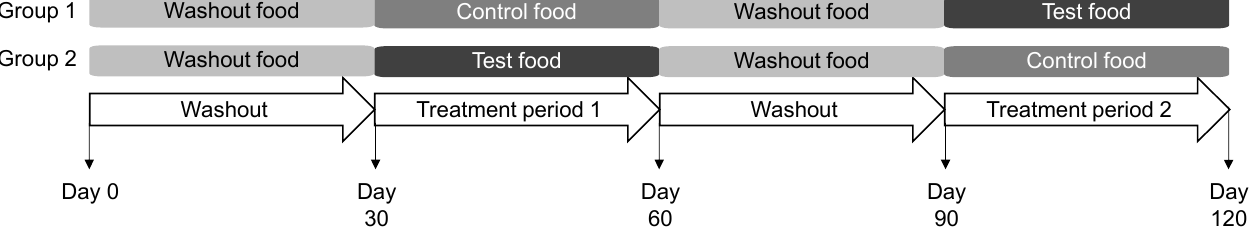
Figure 1. Study design in which cats consumed the washout, control, and test foods.